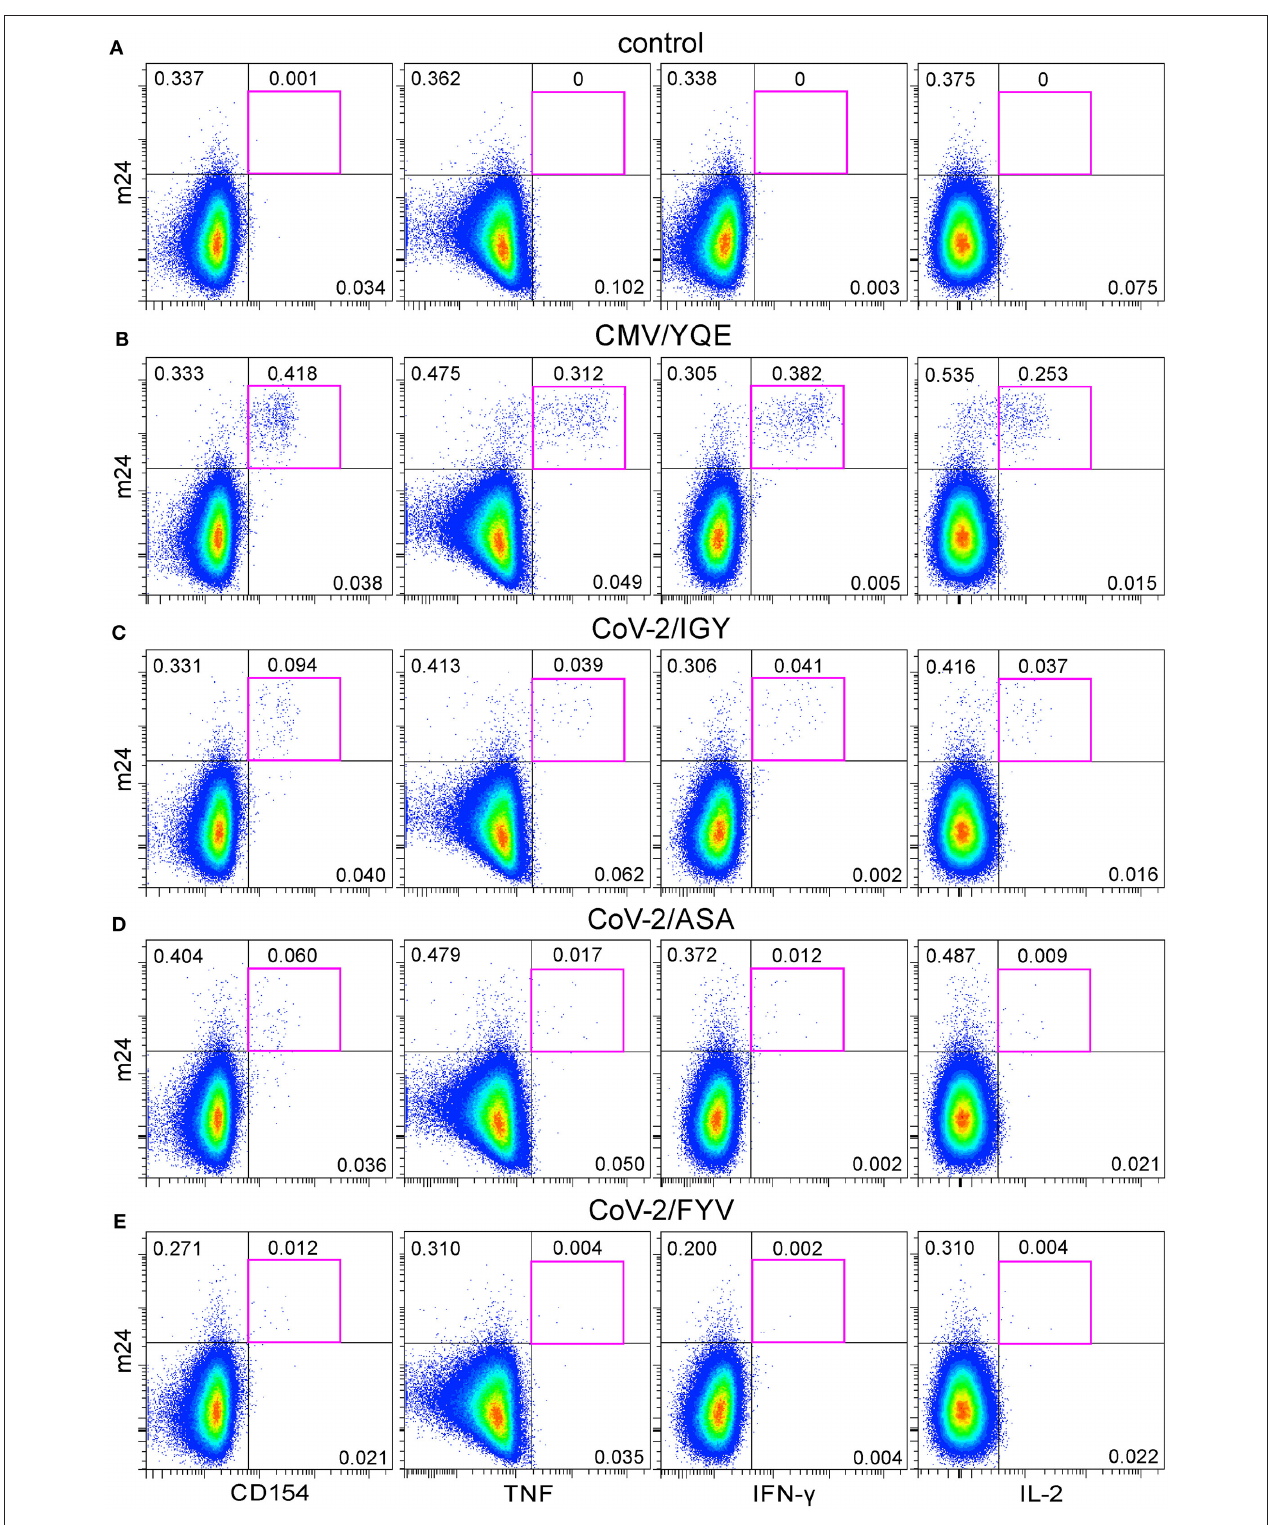
FIGURE 9 | The functional profile of CMV- and SARS-CoV-2-specific CD4 + WB T cells after peptide vaccination. (A–E) m24 Ab staining in combination with CD154, TNF, IFN- γ , or IL-2 expression obtained from a donor vaccinated with one CMV and three SARS-CoV-2 major histocompatibility complex (MHC)-class II peptides without stimulation (control, A ), with CMV/YQE (B) , CoV-2/IGY (C) , CoV-2/ASA (D) , or CoV-2/FYV peptides (E) for 6h stimulation. Numbers indicate frequencies among CD4 + T cells in %. Gating strategy is as shown in Figure 1A .